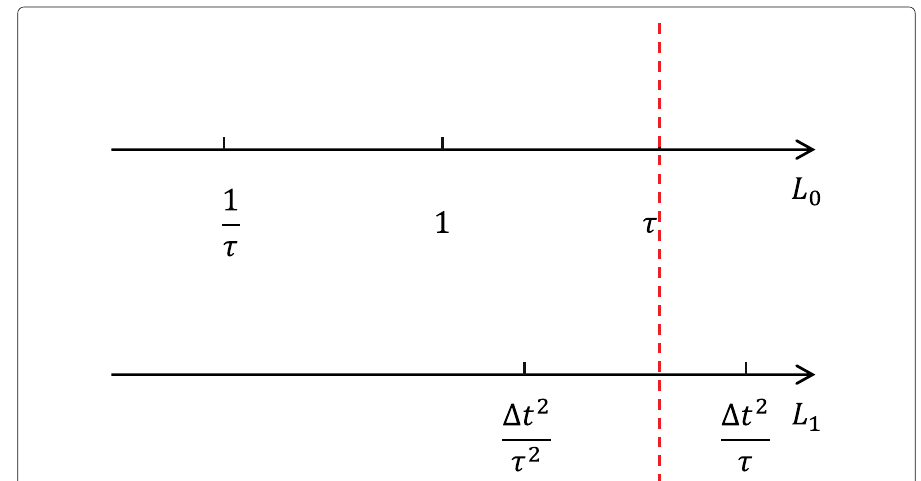
L 1 . Terms that have a higher order than